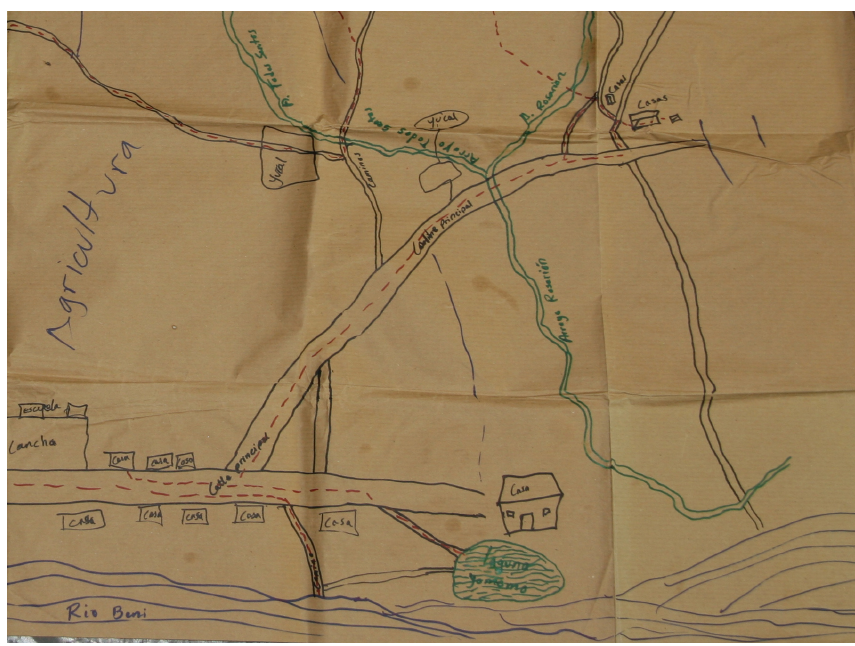
Figure 5. Snippet of a sketch map showing different features.